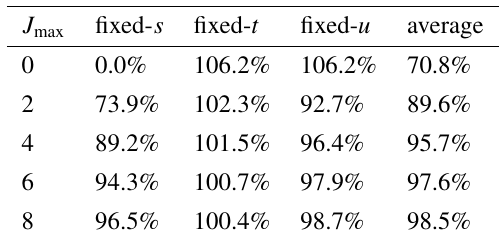
for maximal angular momentum µ J max